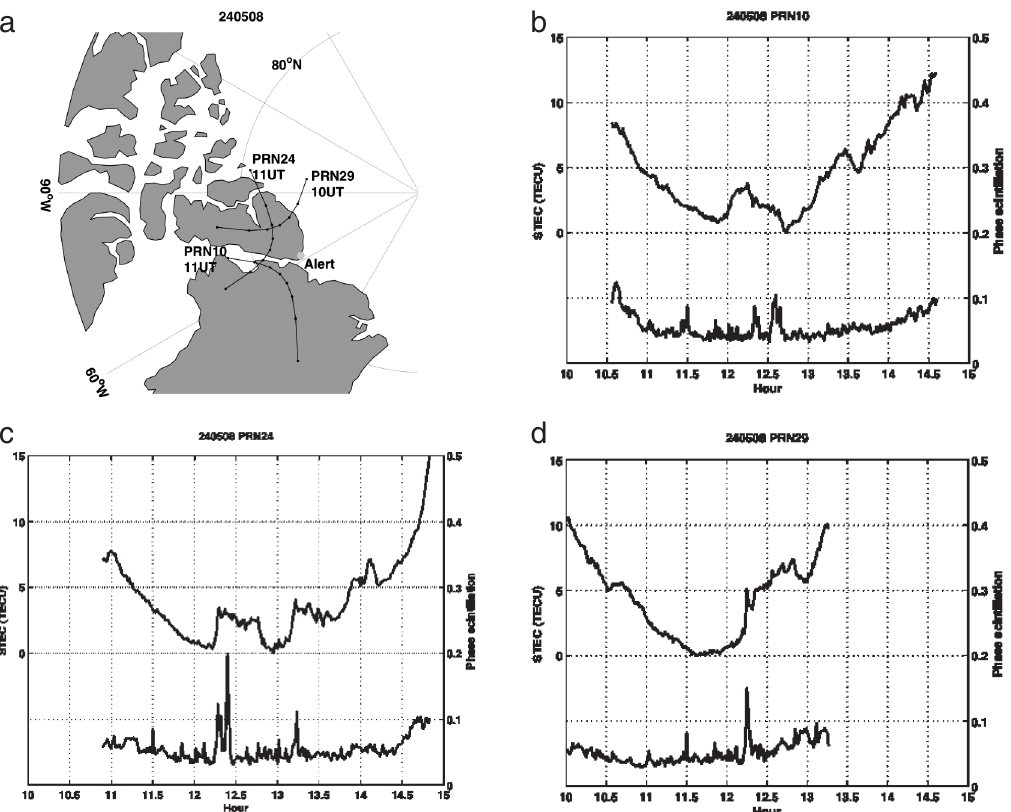
Fig. 6,a-b. Frame (a) indicates the tracks of the 250 km pierce points for satellites PRN10, PRN24 and PRN29 on 8 May 2008. The track starts at the labelled end of the trace at the time stated, and the dots indicate the movement of the pierce point at 30 minute intervals. Frames (b), (b) and (d) show the variation in slant TEC (offset such that the minimum observed value on that satellite pass is shown as zero) and phase scintillation ( σ φ ) as a function of time for satellites PRN10, PRN24 and PRN29